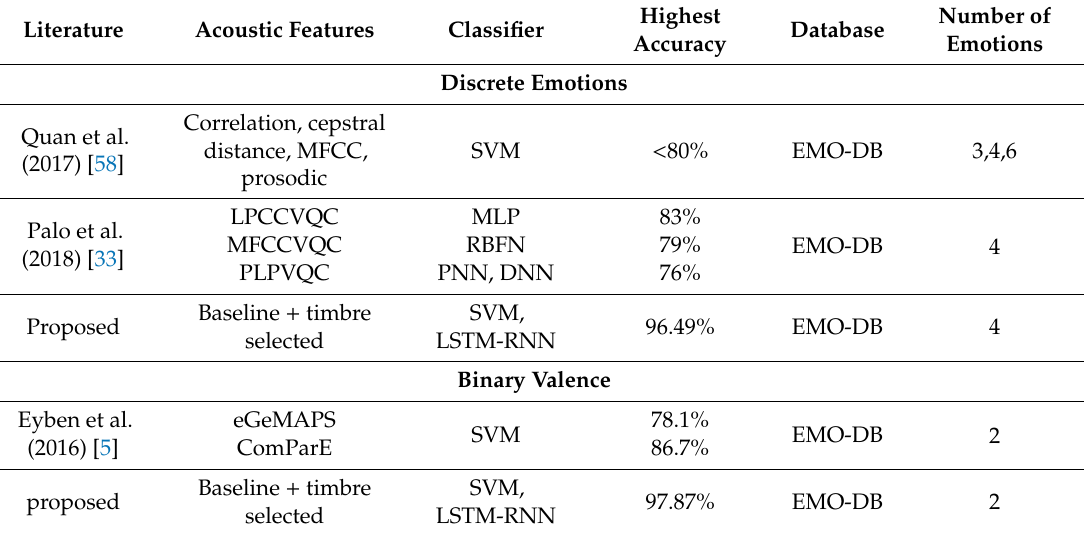
Table 6. Comparison of the results in literature with the proposed acoustic feature set for EMO-DB.